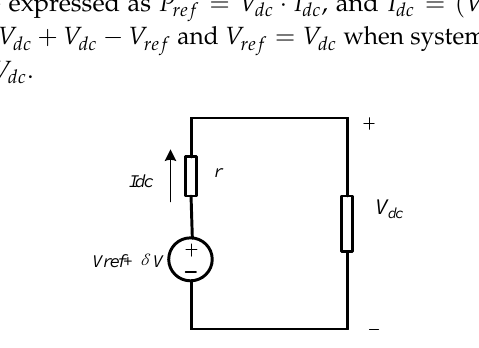
Figure 7. DC side equivalent